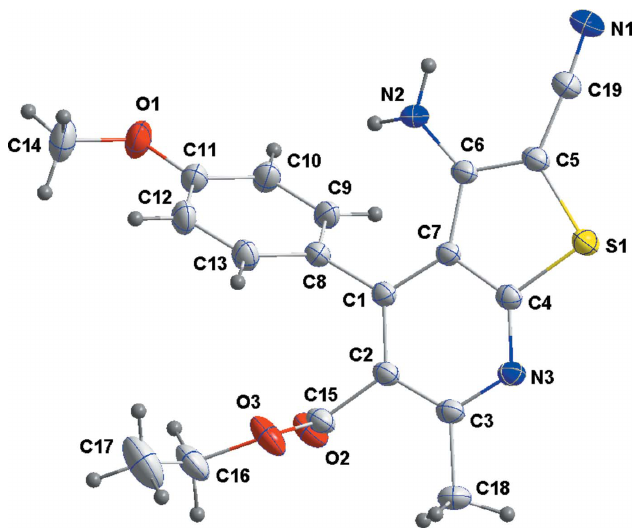
Figure 1 The title molecule with labeling scheme and 50% probability ellipsoids. Only one orientation of the disordered ester group is shown.